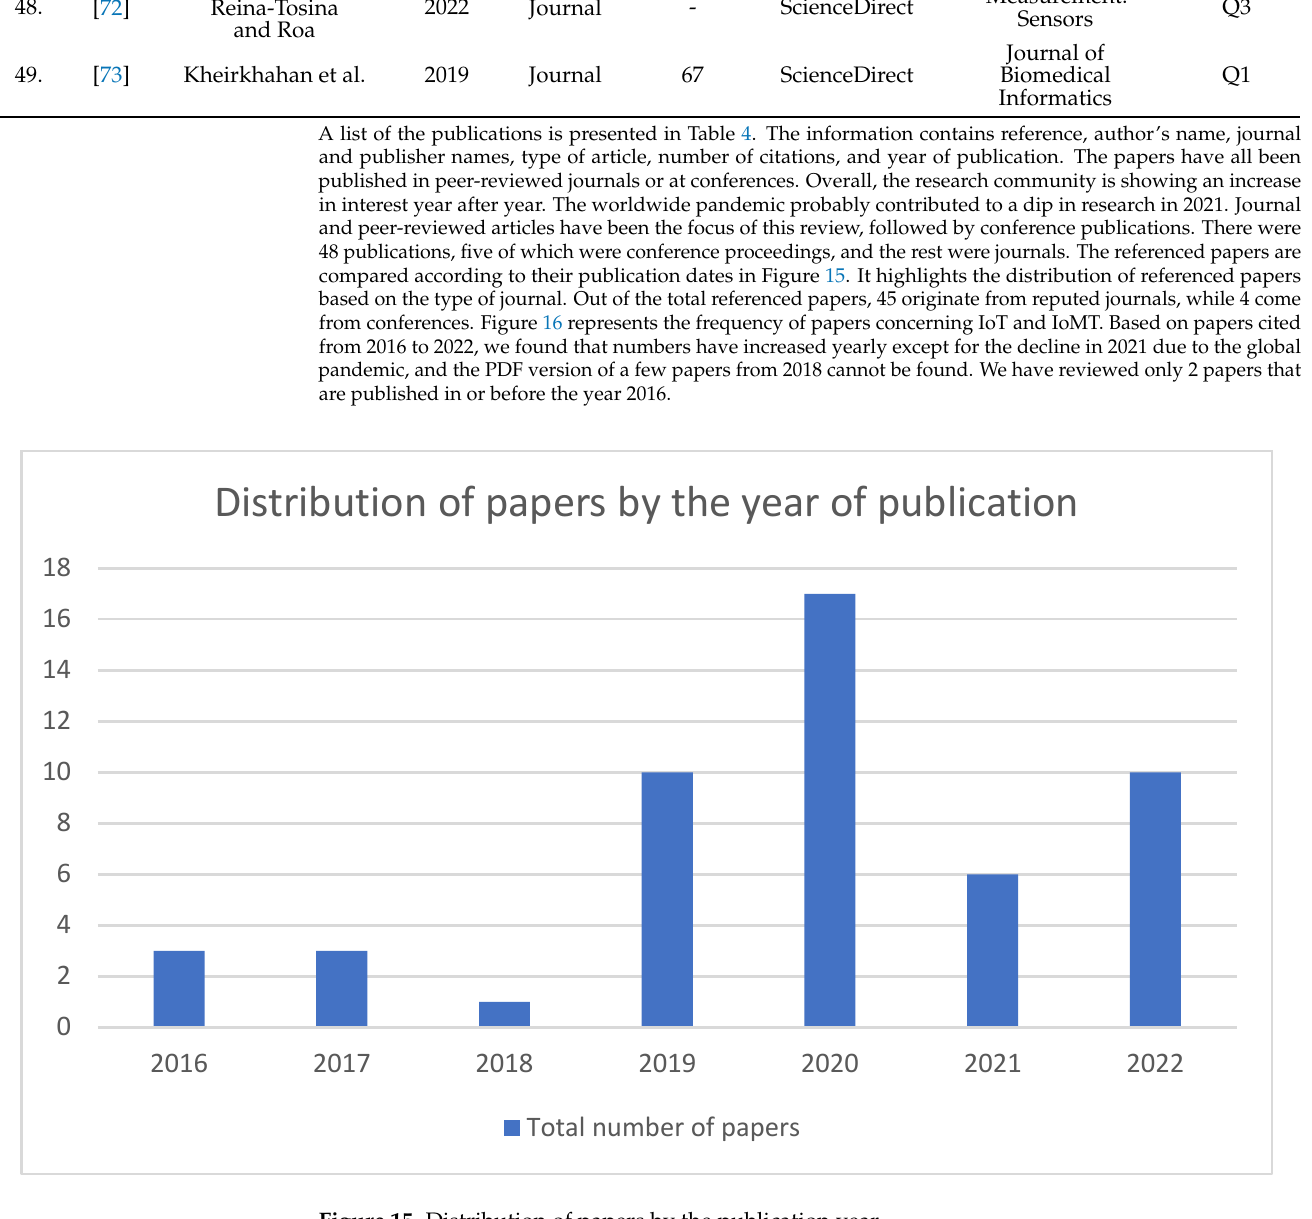
Figure 15. Distribution of papers by the publication year .